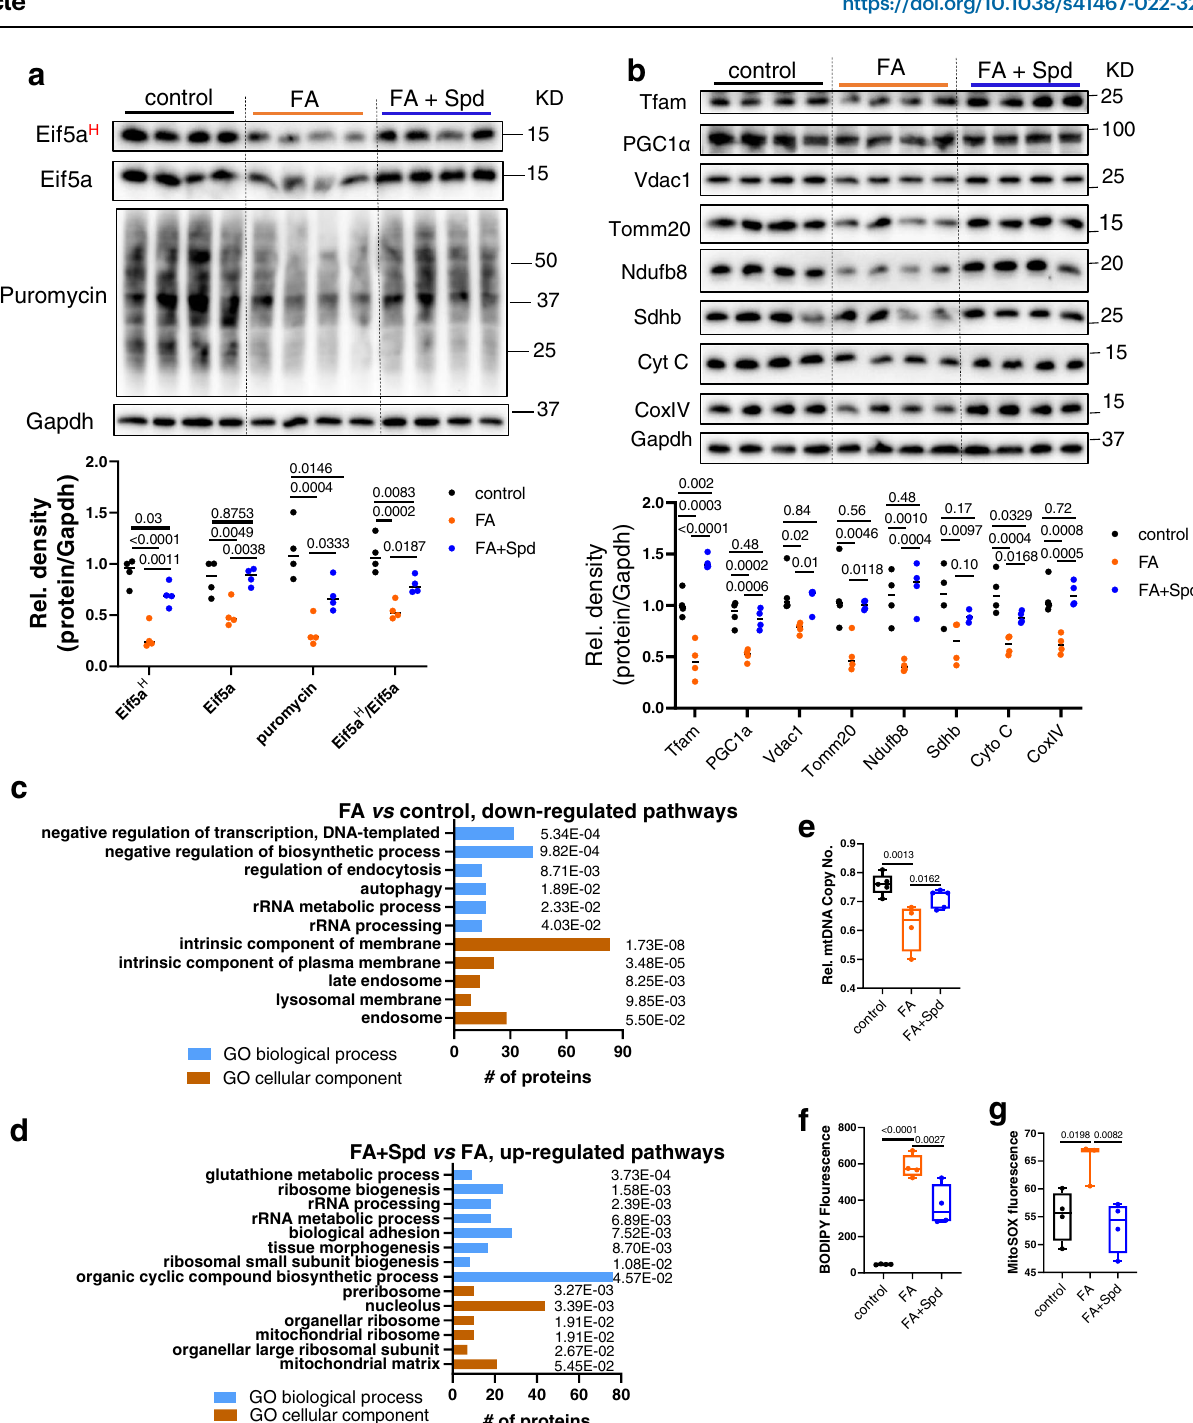
( n =5)), BODIPY fl uorescence ( f , n =4), and MitoSOX measurement of mitochon- drial ROS (( g , control ( n =4), FA ( n =3), FA+Spd ( n =4)) in control, FA − , FA+Spd- treated AML12 cells. AML12 cells were treated with BSA-conjugated FA (palmitic acid 0.6mM, oleic acid 0.17mM) with or without spermidine (Spd, 100 µ M) for 48h. e – g Data were shown as box-and-whisker with median (middle line), 25th – 75th percentiles (box), and min-max values (whiskers). Signi fi cance was cal- culated by one-way ANOVA or Kruskal – Wallis test as appropriate. Source data are provided as a Source Data fi